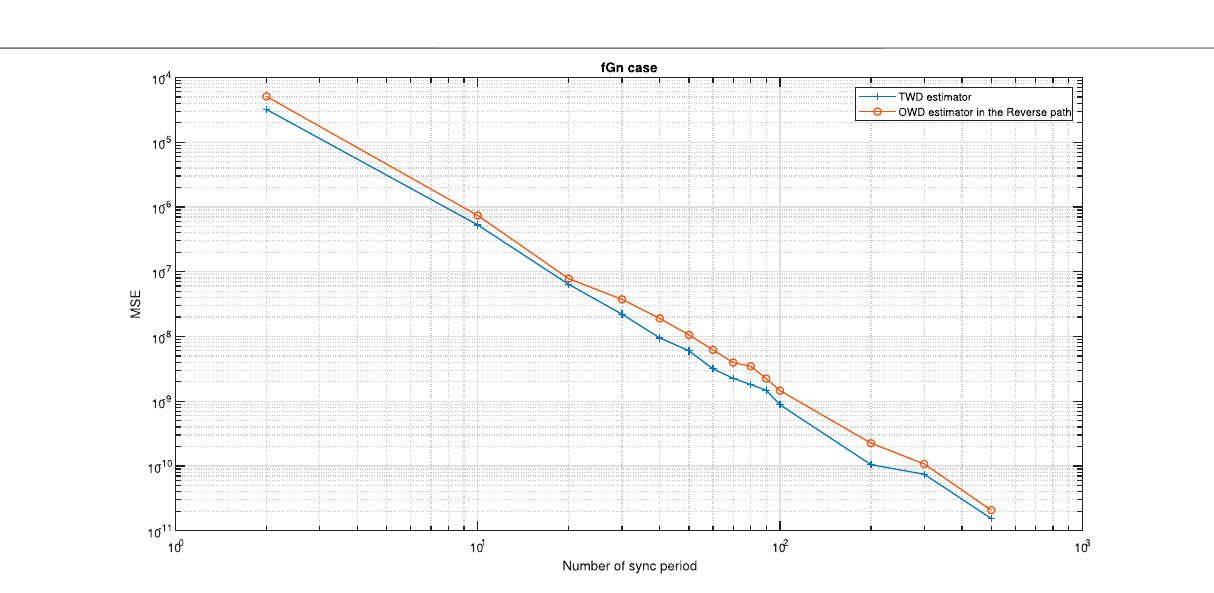
FIGURE 5 | Test case b of Theorem 8. Performance (MSE) comparison between the OWD clock skew estimator in the Reverse path ( Eq. 62 ) and the TWD clock skew estimator ( Eq. 60 ). The PDV is an fGn process. α = 50 ppm , Q = 5 ms , T syn (cid:2) 15 . 6 ms ( 64 packet σ 2 (cid:2) 1 e − 8 [ sec 2 ] , Z = 0.69, (cid:2) Z ( J (cid:2) 500 ) (cid:2) 0 . 3427 (for J < 500, (cid:2) Z ω 2 fGn / gfGn